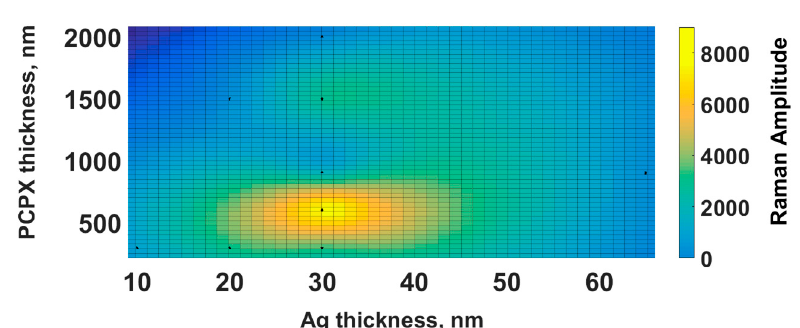
Figure 5. 2D representation of the dependence of the SERS signal on the silver layer thickness and the thickness of the PCPX layer on the substrate.